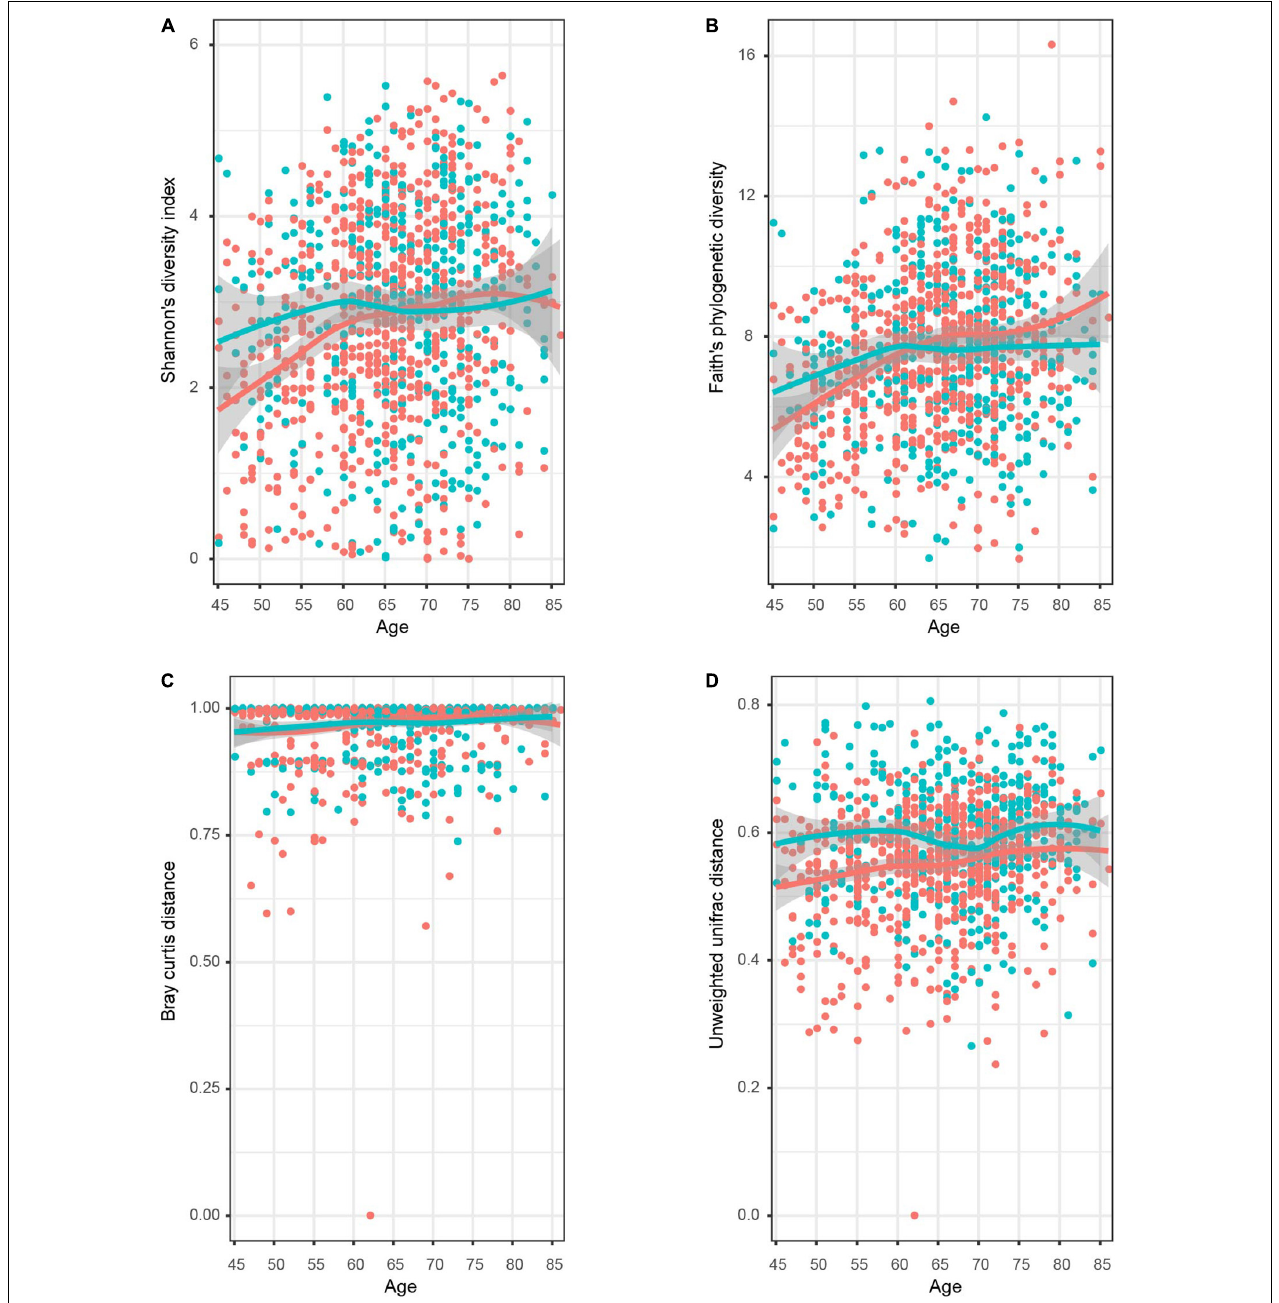
FIGURE 3 | Dynamic response pattern for the microbial alpha and beta diversity of genitourinary microbiome along with the age. The four plots displayed (A) Shannon’s diversity index, (B) Faith’s phylogenetic diversity, (C) Bray–Curtis distance, and (D) unweighted UniFrac distance. The smooth curves are formed for female (red colored) and male (blue colored) individuals using the geom_smooth function in